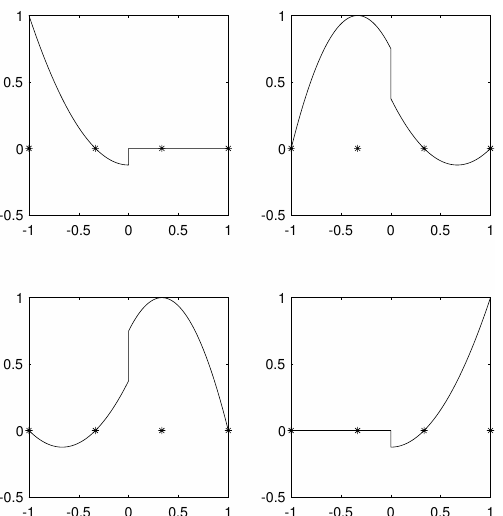
Figure 4. Piecewise cardinal function example. Clockwise starting from the top left: l 1 ( x ) , l 2 ( x ) , l 4 ( x ) , l 3 ( x )